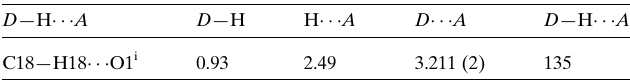
Table 1 Hydrogen-bond geometry (A˚ , (cid:2) ).